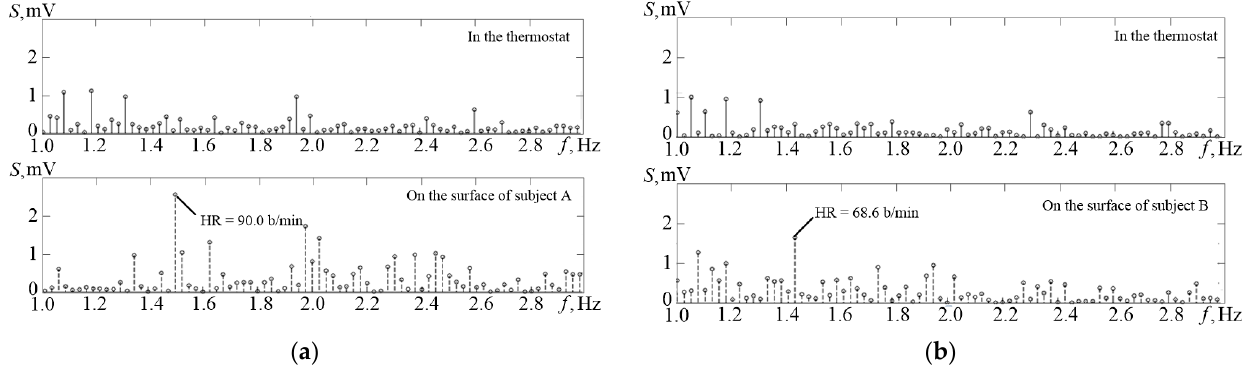
Figure 12. Comparison of the amplitude spectrum of the TO signals obtained when the temperature sensor is placed into the thermostat (the upper parts of graphs ( a , b )) and when placed on the surface of the body of test A and test B (the lower parts of graphs ( a , b )). The lower graphs clearly distinguish the frequency components corresponding to the average pulse frequencies of the subjects, 90.0 and 68.6 bpm.